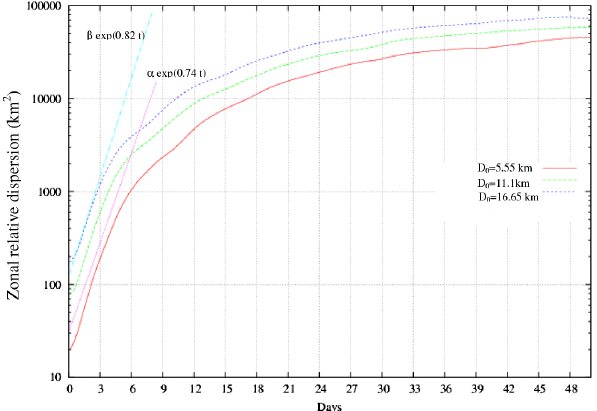
Fig. 5b. The zonal relative dispersion versus time and D 0 . The α exp ( 0 . 74 t) and β exp ( 0 . 82 t) laws are given with α = 30 and β =